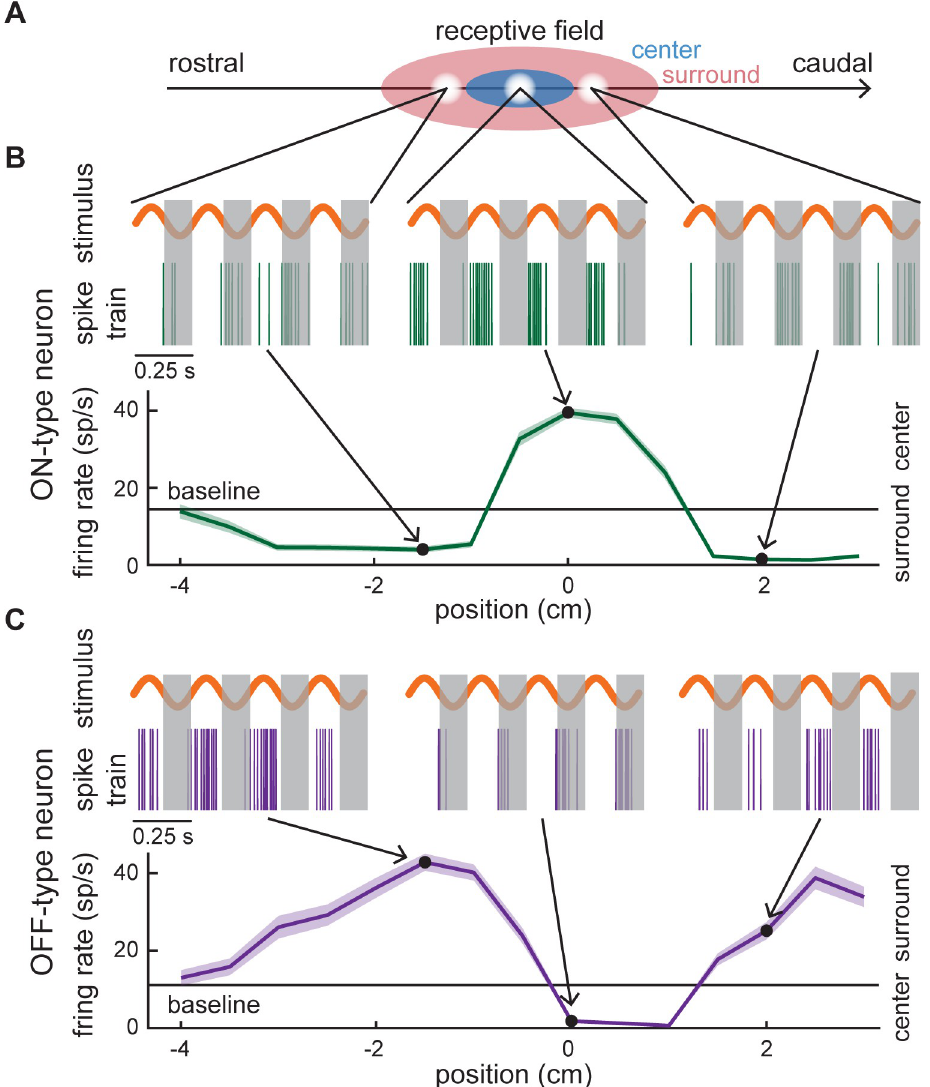
Fig 2. Mapping the receptive fields of ON and OFF-type pyramidal cells. (A) Schematic of a receptive field with the center (blue)—surround (red) organization and stimulation paradigm. A dipole delivering a local stimulus (white circles) is systematically moved from rostral to caudal positions to map the receptive fields of the recorded neurons. (B) Top : Neural responses from an example ON-type pyramidal cell to stimulation at different locations on the rostro- caudal axis (spike train, green). The positive half-cycle of each repetition, or trial, of the stimulus (orange) was analysed. The grey bands cover the negative half-cycle of the stimulus. Bottom : Trial-averaged firing rate (green) as a function of stimulus position (i.e., the receptive field) for this example cell, with shaded error bars indicating the SEM. The responses corresponding to the three positions shown in (A) are marked by arrows and black dots. The receptive field center and surround were defined as the regions in space for which the firing rate was either greater or lesser than the baseline firing rate (horizontal black line), respectively. (C) Same as (B), but for an example OFF-type pyramidal cell (purple). In this case the receptive field center and surround were defined as the regions in space for which the firing rate was either lesser or greater than the baseline firing rate,